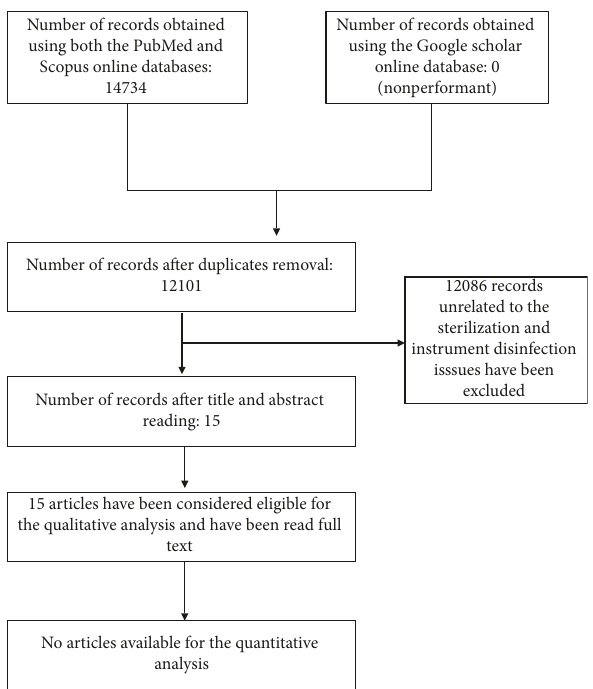
Figure 1: PRISMA flow diagram illustrating the process of se- lection of the eligible articles used in this